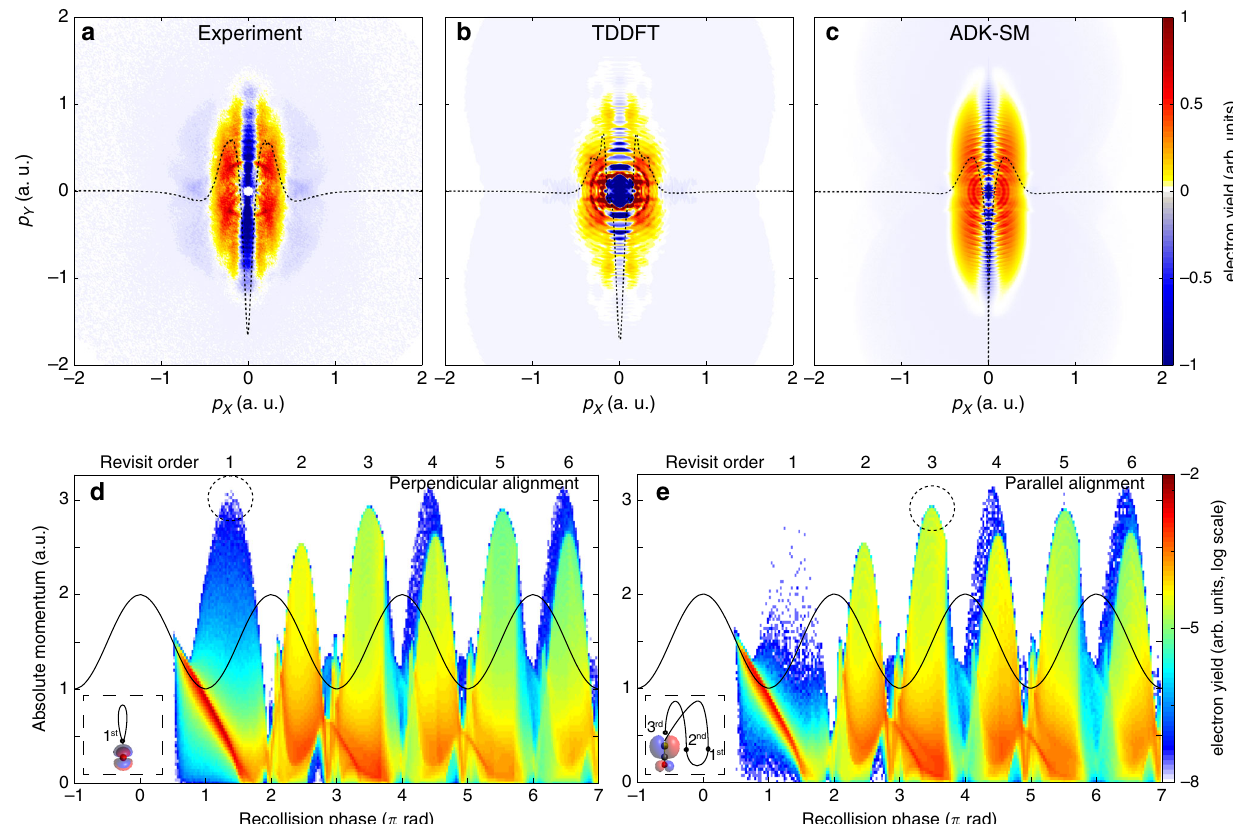
Fig. 3 Differential momentum distributions and simulated fi nal absolute photoelectron momentum. a – c Differential momentum distributions (parallel – perpendicular) from ( a ) the experiment, and the ( b ) TDDFT and ( c ) ADK-SM calculations. To estimate the difference of the transverse momentum component the signal is integrated along the Y axis, shown by the black dashed lines. d , e Final absolute photoelectron momentum as a function of the recollision phase (bottom) and revisit order (top) for d perpendicular and e parallel alignment, calculated with ADK-SM. The colour scale maps the electron counts at every momentum-phase point. The dashed black circles highlight the largest-momentum electrons at the most probable revisit order for the two alignments. A distance of r < 5 atomic units between electron and point charge is interpreted as a collision and only electrons with exactly one collision are shown. The solid black line depicts the external electric fi eld. The insets give pictorial representations of molecular-frame electron trajectories, where the cardinals represent the revisit